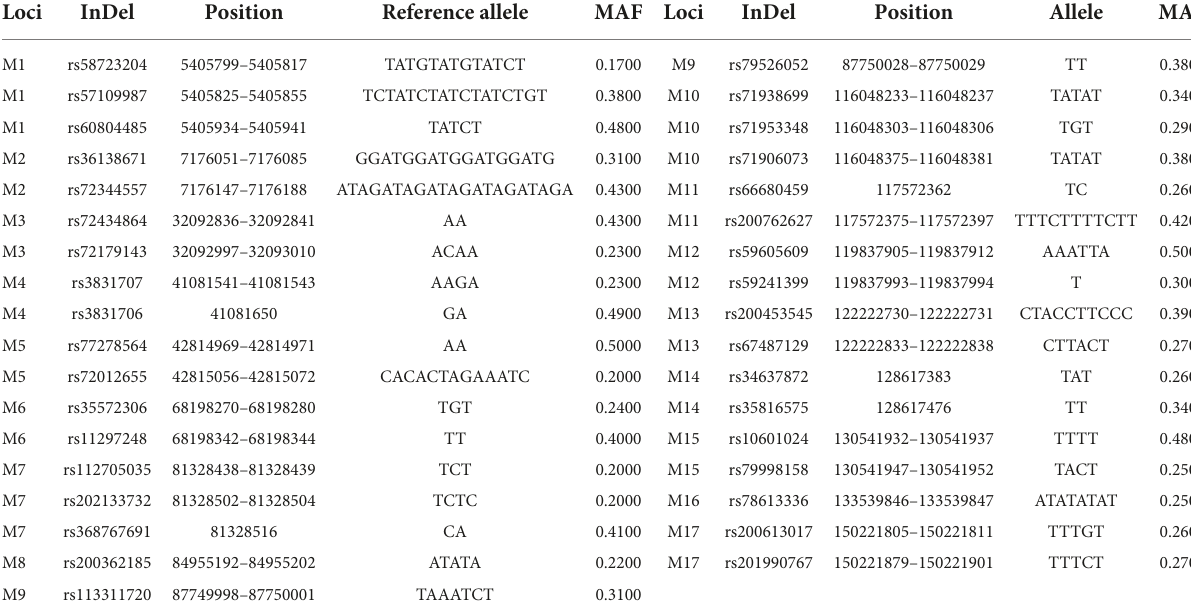
TABLE 1 General information of 17 selected Multi-InDel loci on the X chromosome. Loci